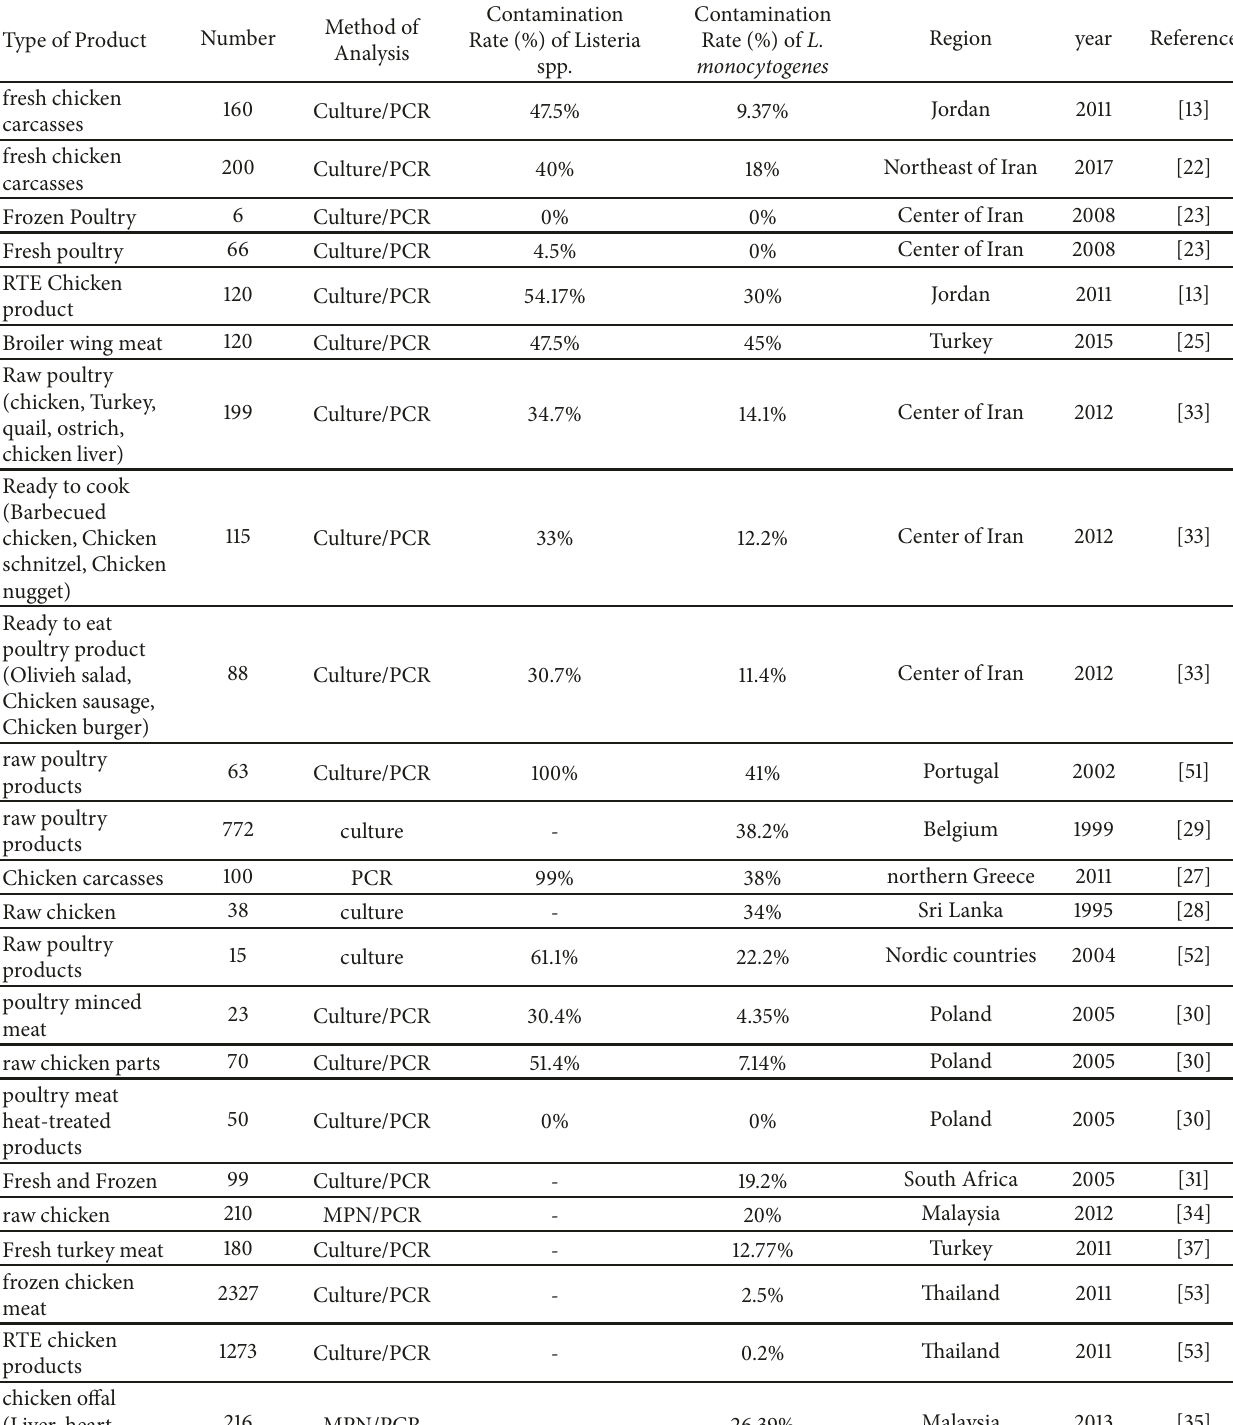
Table 2: Prevalence of Listeria spp. and L. monocytogenes in poultry meat and